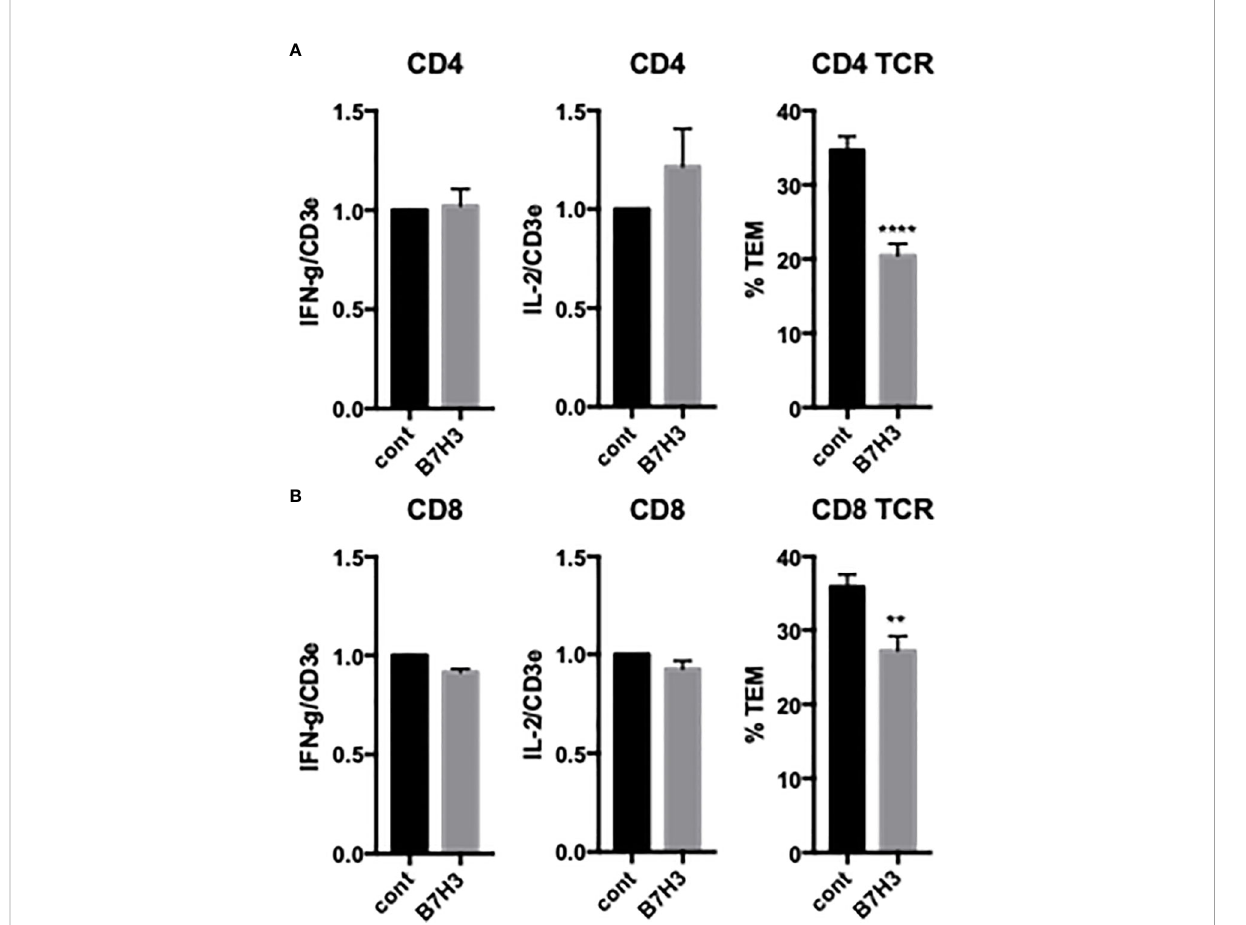
FIGURE 4 Effects of EC B7H3 on cytokine expression and TCR-TEM of CD4 and CD8 T EM . Cytokine expression and TCR-TEM of CD4 (A) and CD8 (B) T EM on CIITA-transduced HDMEC treated with control or B7H3 siRNA, activated with TNF 24 h, and overlaid with TSST-1 30 min and assayed as described in Figure 1. **p<0.01;